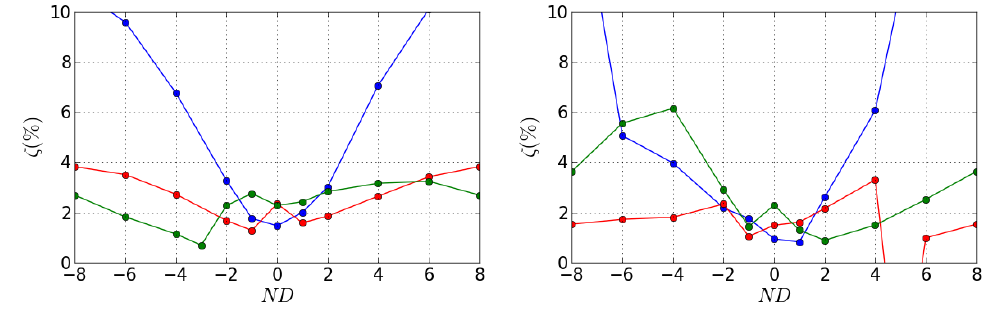
Figure 15. Aerodynamic damping as a function of nodal diameter: ( left ) OP-A; ( right ) OP-B.